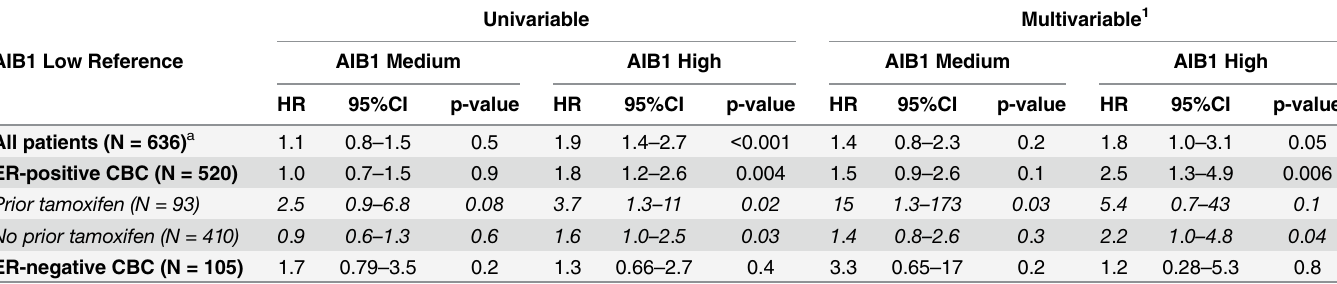
Table 3. Prognosis after CBC in relation to AIB1-status of BC2.